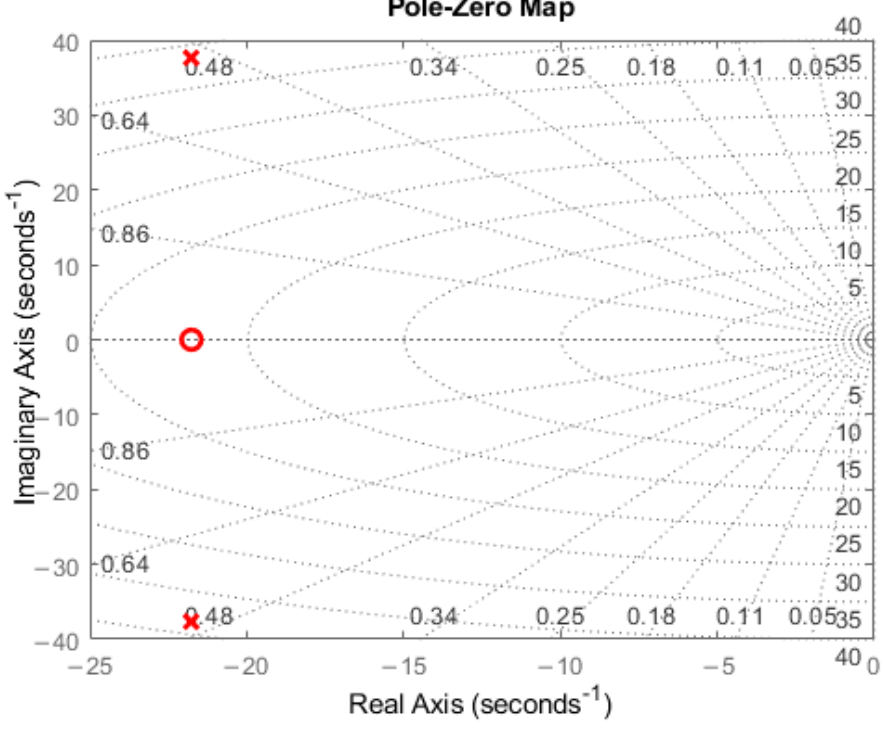
Figure 2. The pole–zero map of the analyzed control structure.